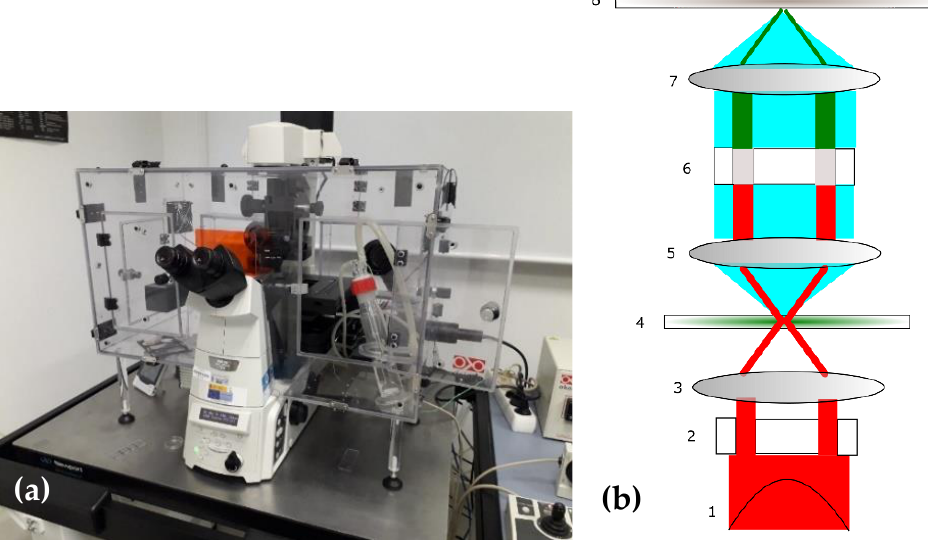
Figure 1. ( a ) Phase-contrast microscope employed for imaging the fresh samples; ( b ) Schematic representation of the phase-contrast microscope, with the non-scattered (in red) and scattered (in blue) optical fields: 1, optical source; 2, condenser annulus; 3, condenser; 4, sample; 5: collimating lens; 6, phase and attenuation filter; 7: imaging lens; 8: image plane.